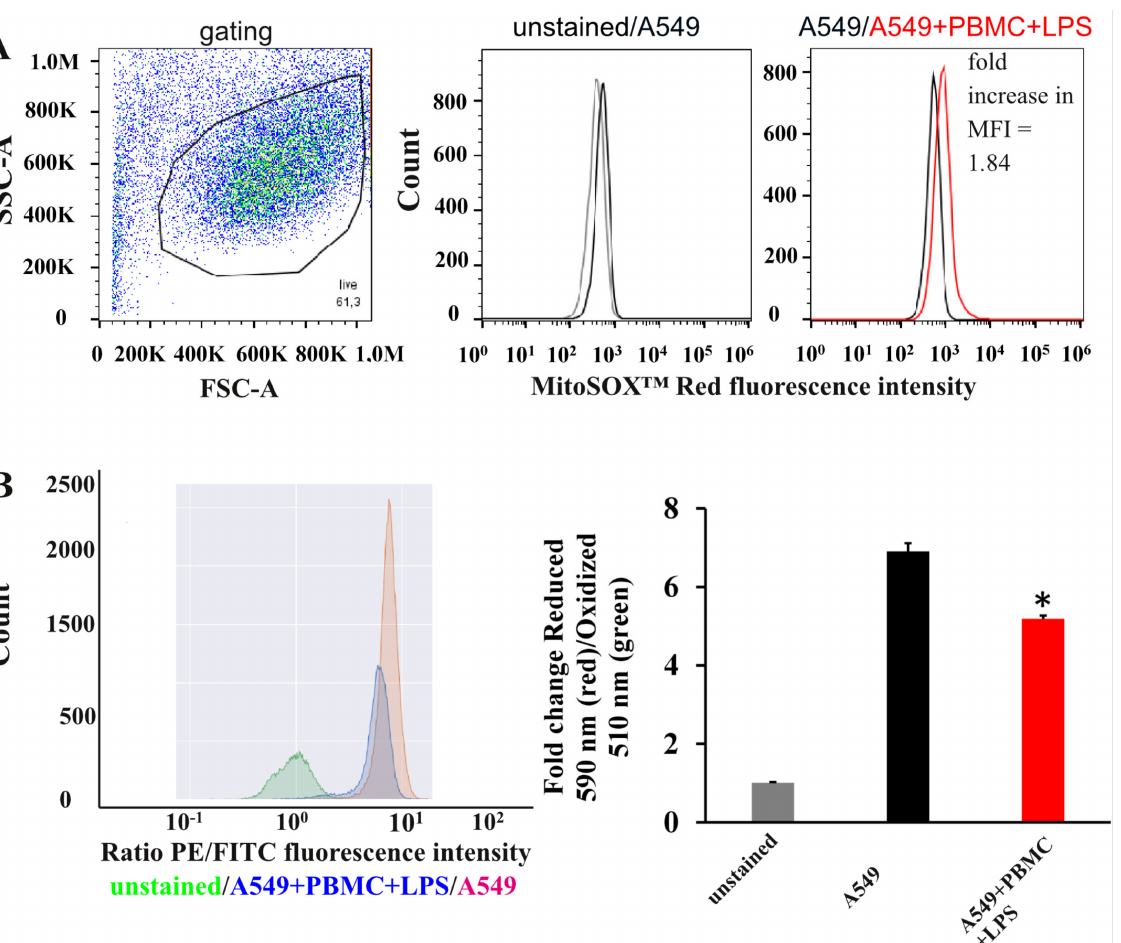
Figure 4. Effect of cocultivation with activated PBMC on ROS generation in A549 cells. ( A ) Evaluation of mitochondrial ROS production by MitoSOX TM Red. The left figure illustrates flow-cytometric dot plots showing gating of A549 cells. The central figure shows a histogram of cytometric analysis of MitoSOX TM Red on A549 cells unstained (gray) and intact A549 cells were stained with MitoSOX TM Red (black). The right figure shows a histogram of cytometric analysis of MitoSOXTM Red on intact A549 cells (black) and A549 cells were collected 24 h after the modeling of inflammation (red). ( B ) Red/green fluorescence intensity ratio, indicating an increase in lipid peroxidation in A549 cells estimated by Image-iT™ Lipid Peroxidation Kit. Histograms represent the ratio of red to green in A549 cells. Data are presented as a mean ± SEM, n = 3. * p < 0.05 vs. A549 as determined by t -test. MFI—mean fluorescence